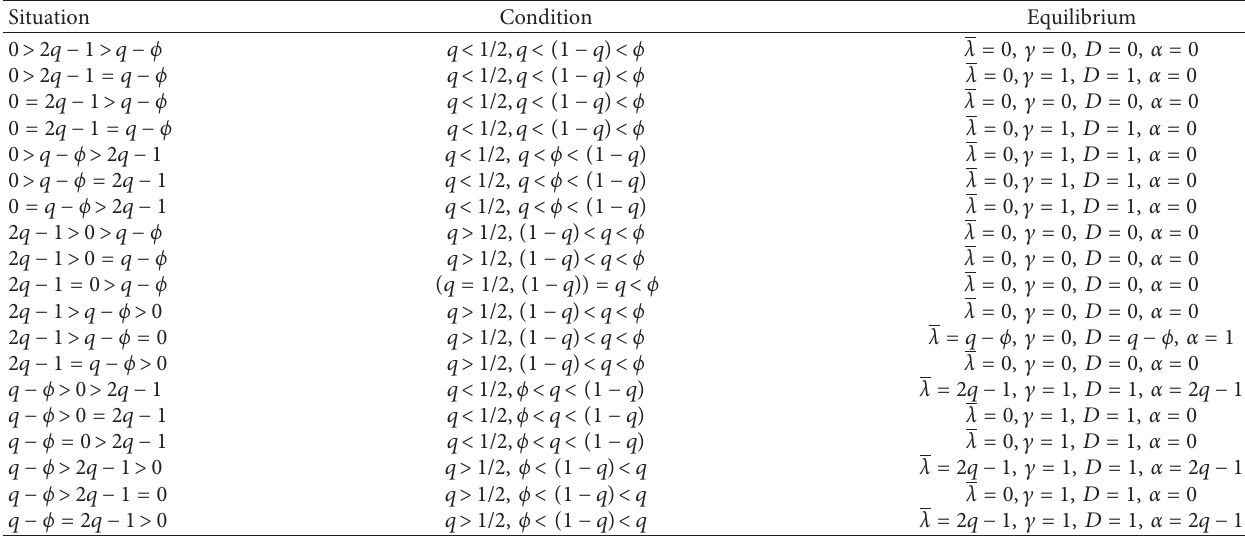
Table 2: List of equilibria in all candidate situations.